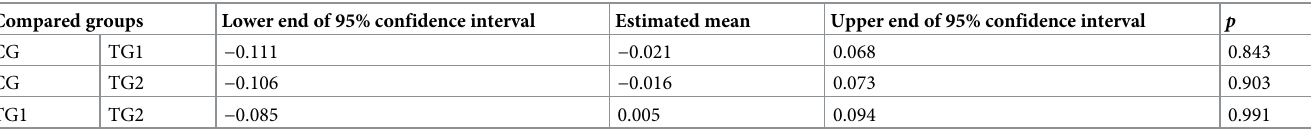
Table 5. Comparison of pre-intervention attitudes toward IT innovations ( Q pre ) for future generations (future generations). Compared groups